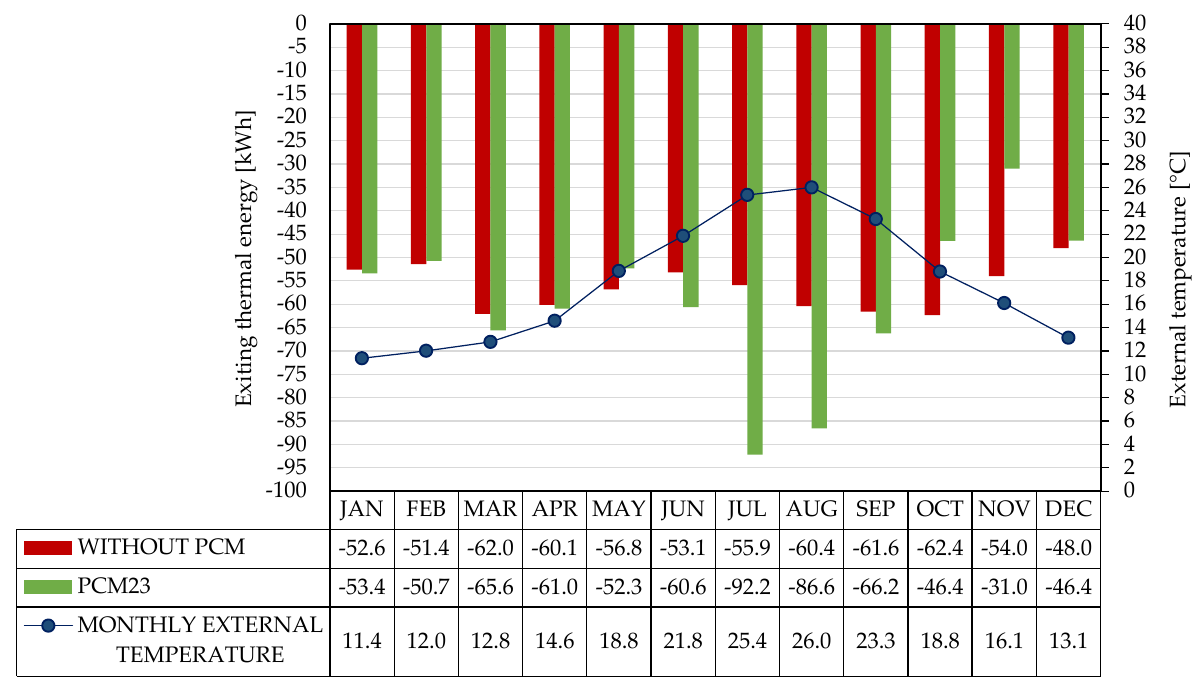
Figure 11. Comparison of the exiting thermal energy through the SuberWall panel between CASE 1 and CASE 2 with PCM23.